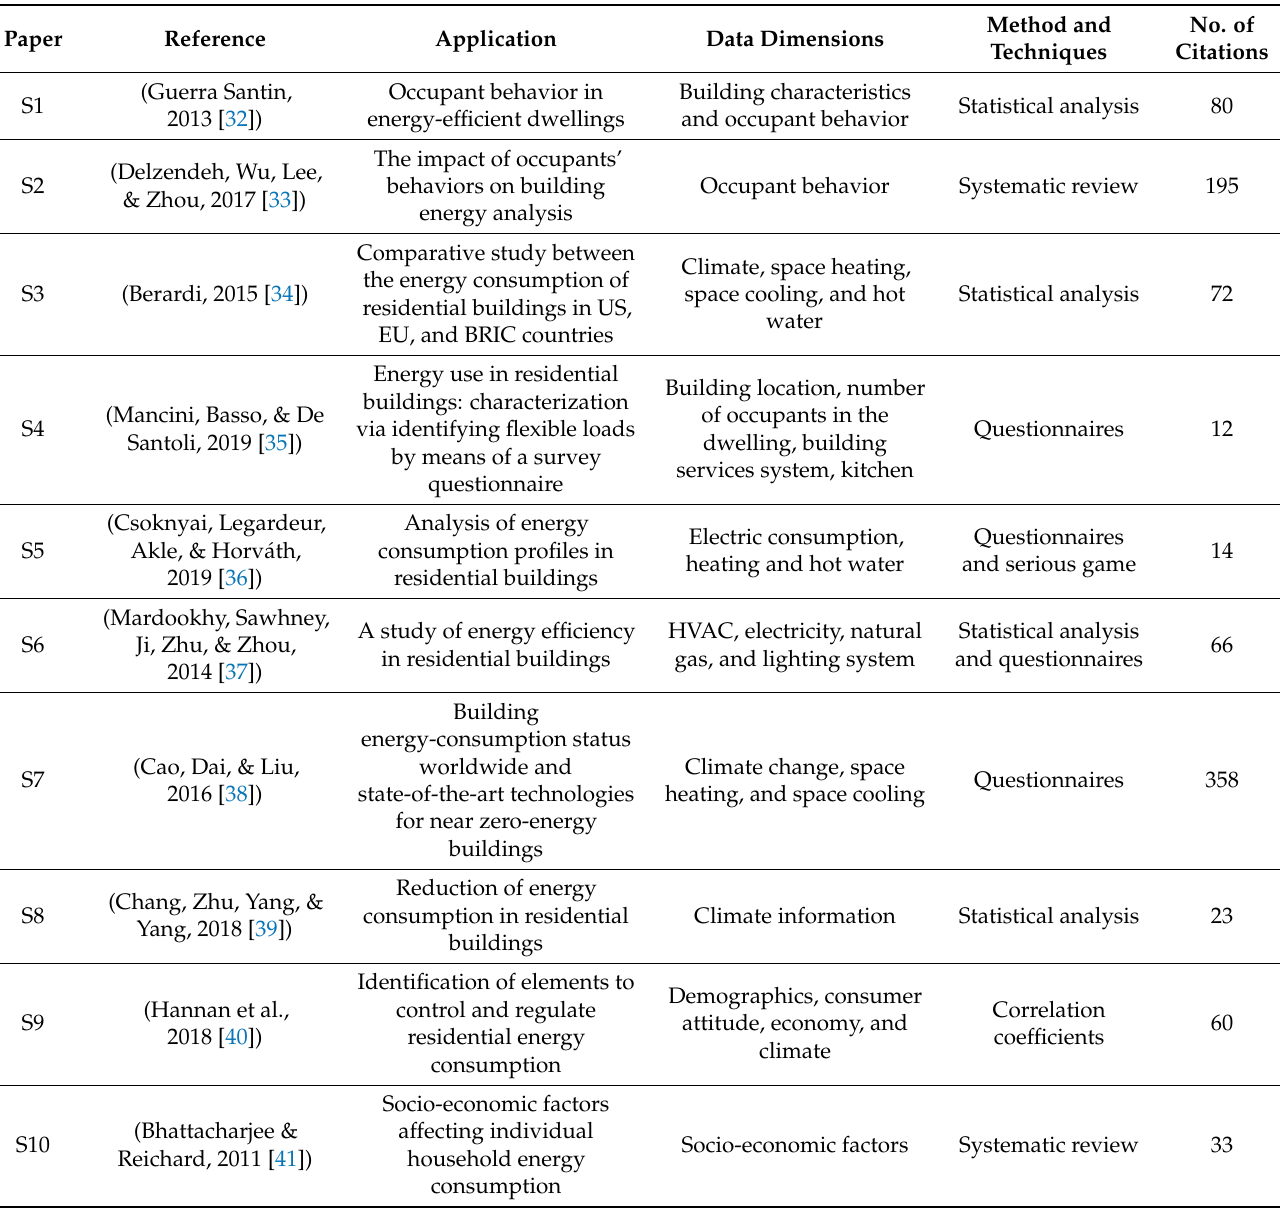
Table 1. Summary of papers in the category of energy consumption of